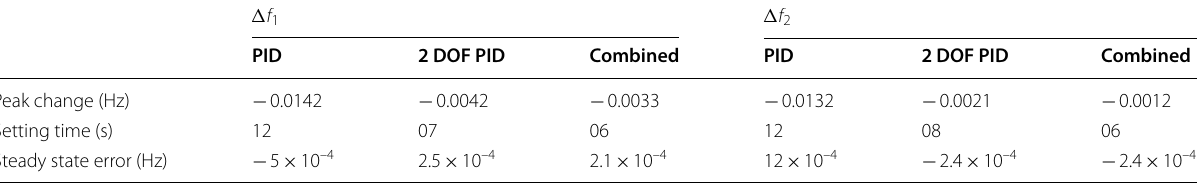
Table 5 Comparison of performance specifications during decreasing mode of wind